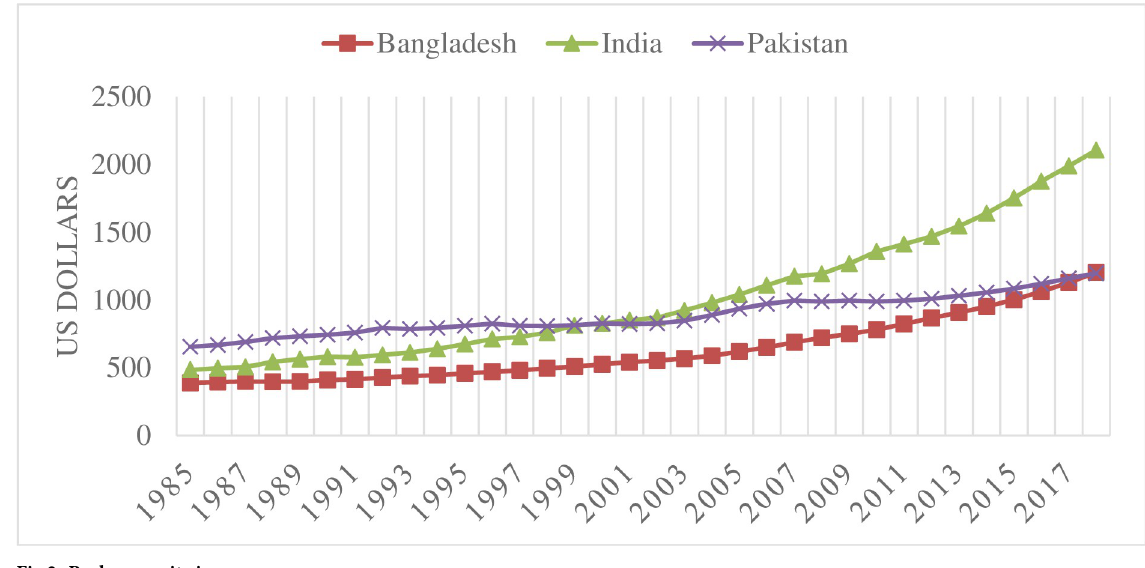
Fig 2. Real per capita